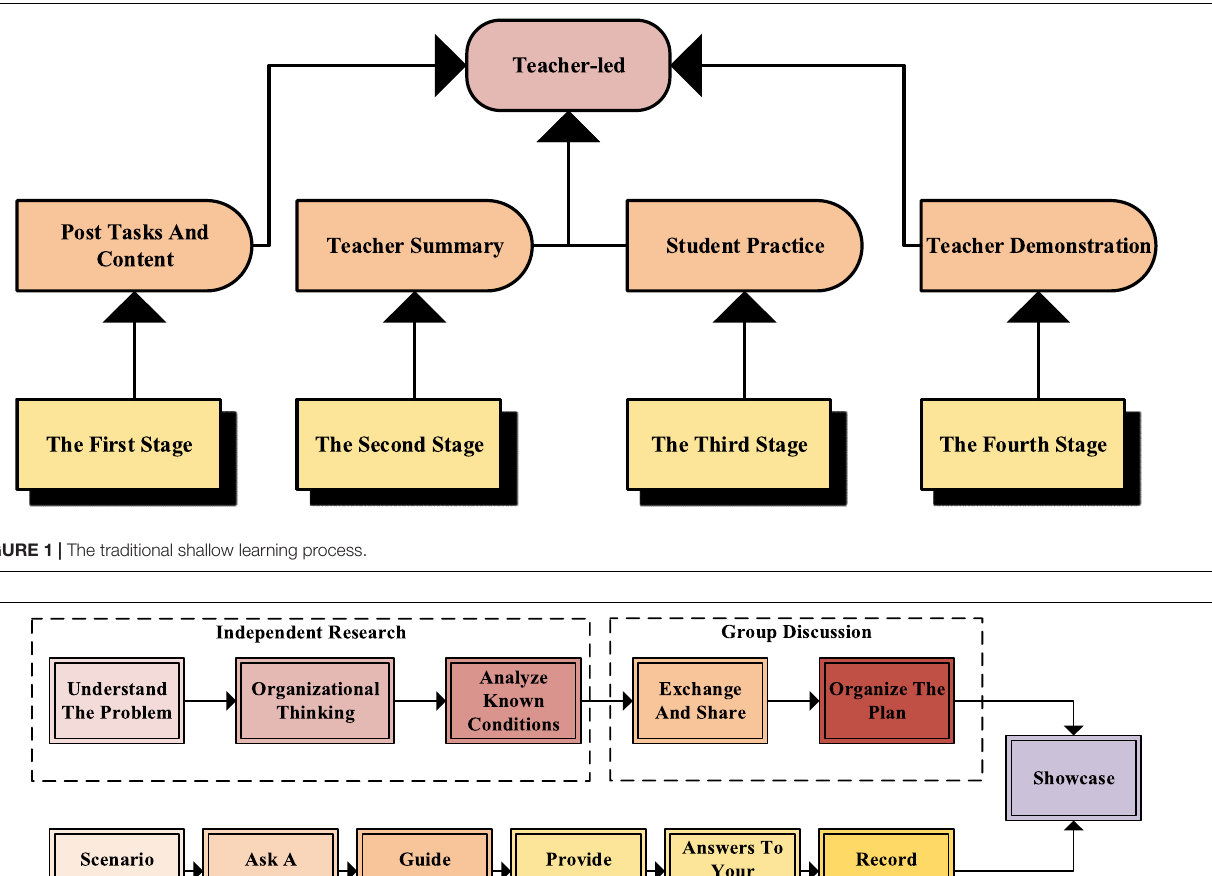
FIGURE 2 | The flow of new deep